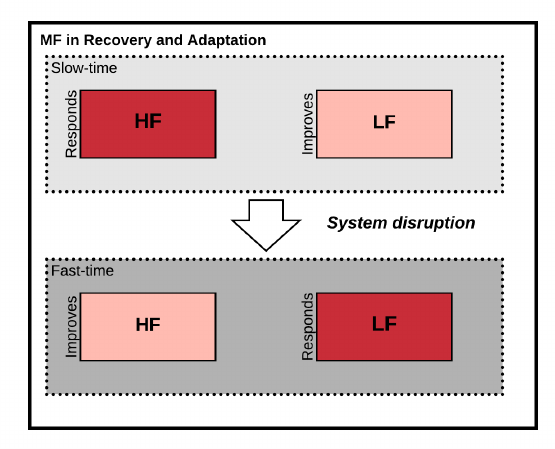
Figure 2. Framework for MF application in adapta- tion and